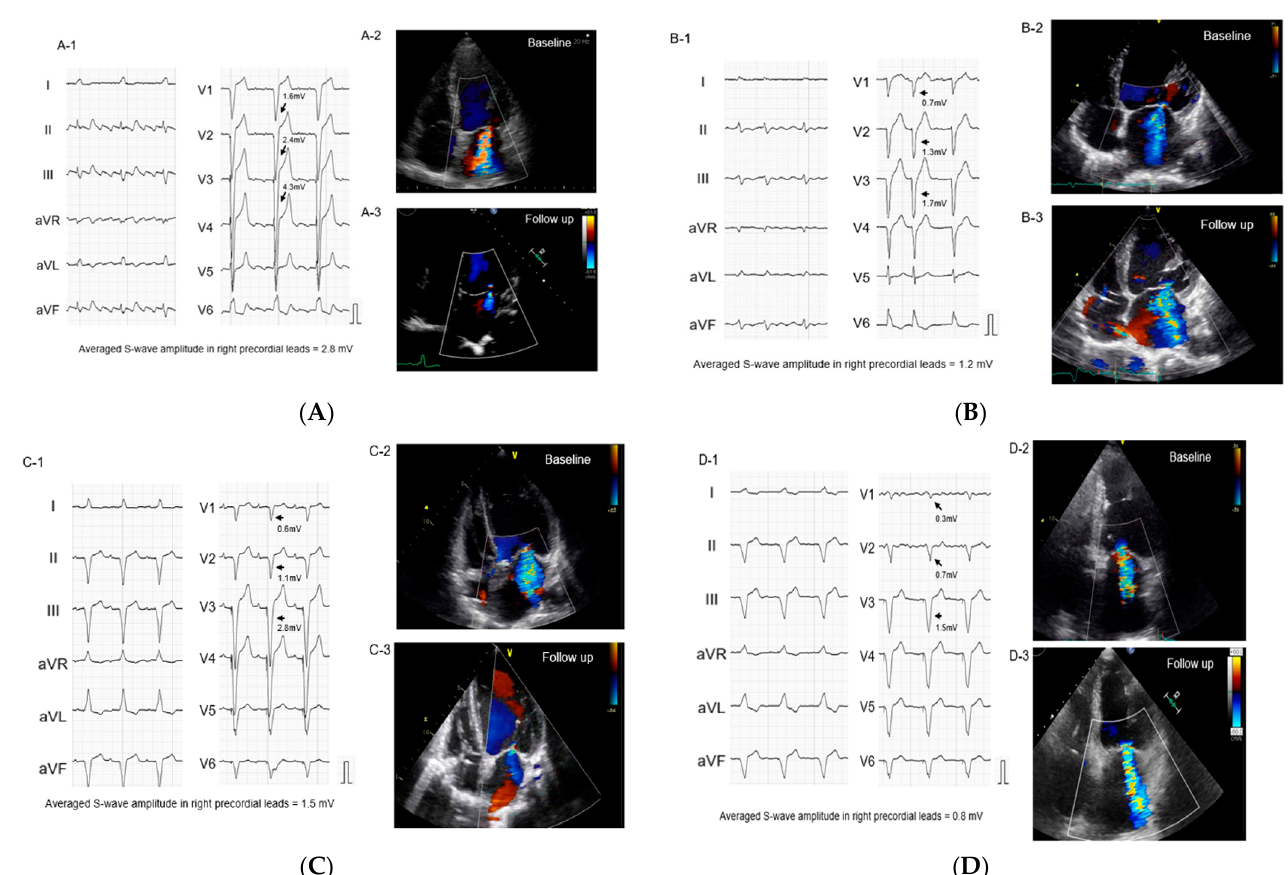
Figure 2. Representative baseline electrocardiograms (left bundle branch block ( A , B ), right ventricular apical pacing ( C , D )). Arrows indicate S-waves in right precordial leads. ( A ). Left bundle branch block and averaged S-wave amplitude >1.3 mV: the patient with MR reduction ( B ). Left bundle branch block and the averaged S-wave amplitude <1.3 mV: the patient without MR reduction ( C ). Right ventricular apical pacing and the averaged S-wave amplitude >1.3 mV: the patient with MR reduction ( D ). Right ventricular apical pacing and the averaged S-wave amplitude <1.3 mV: the patient without MR reduction.